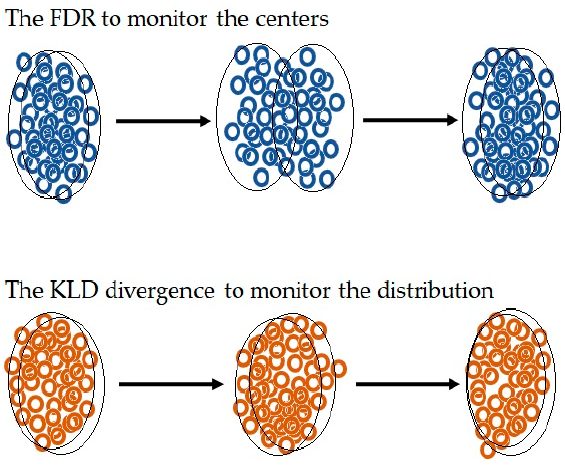
Figure 2. Center and distribution behavior of clusters.